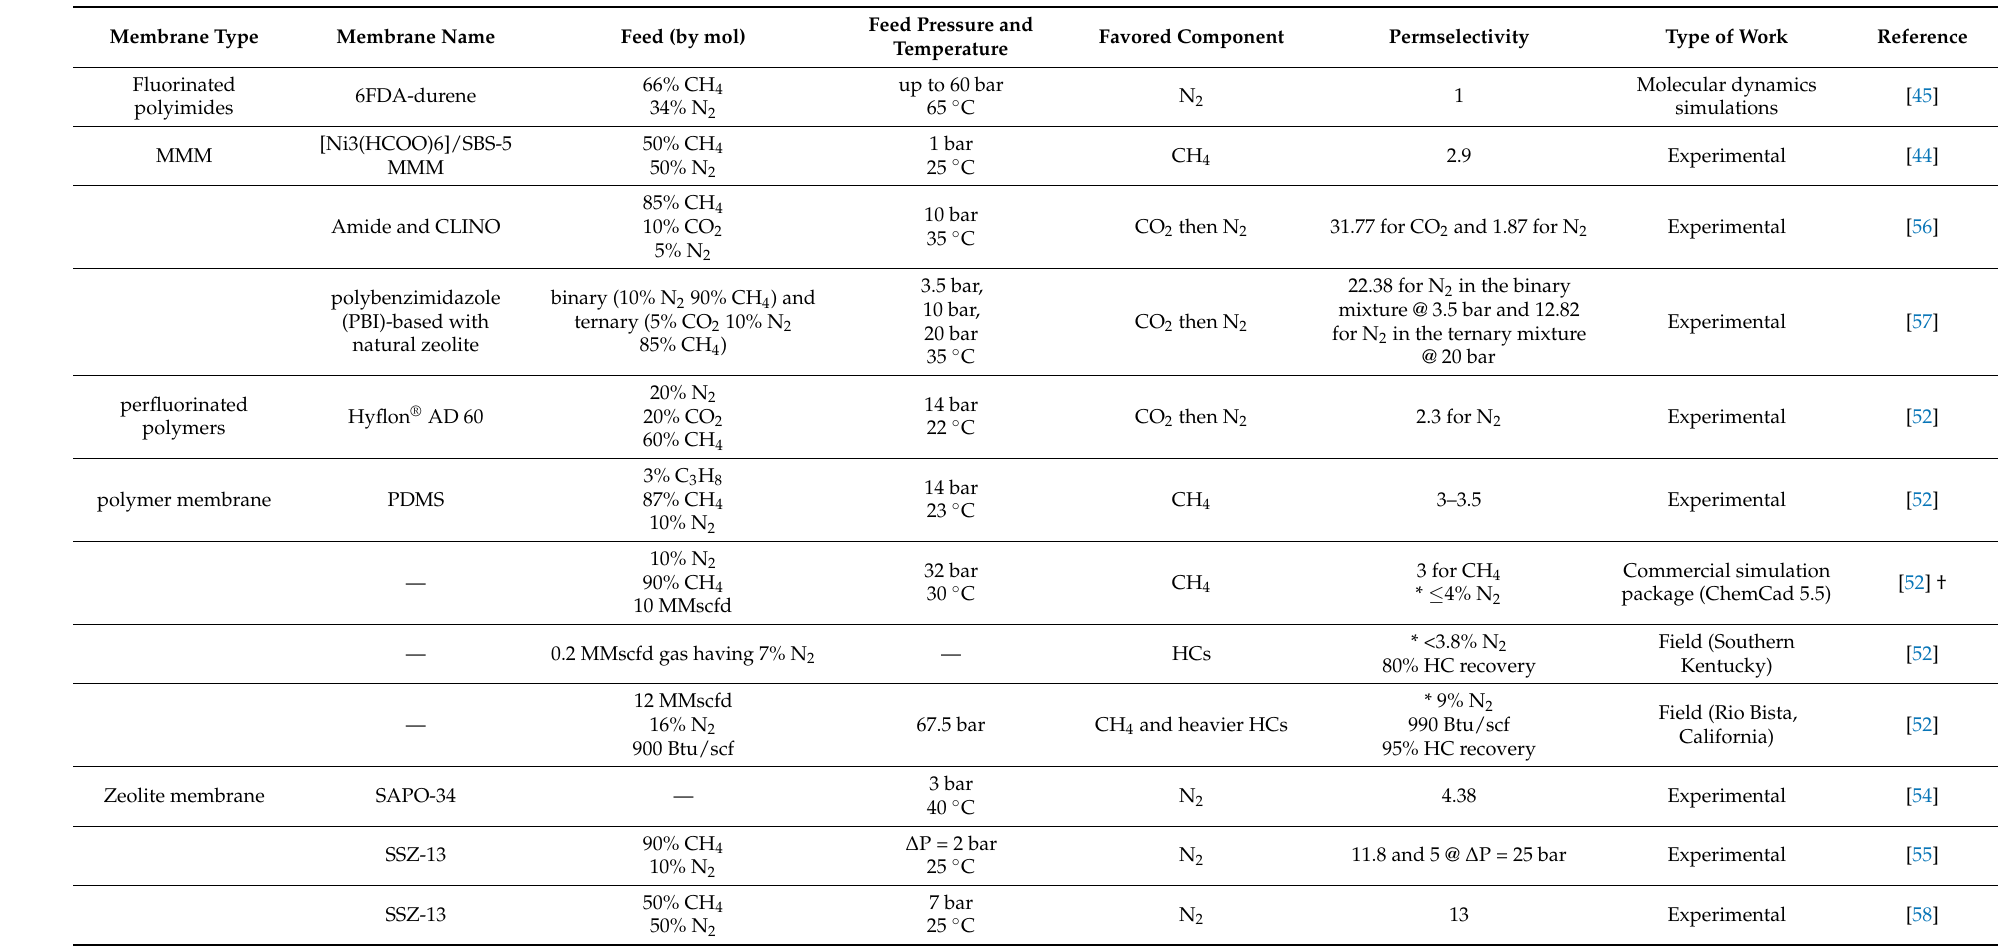
Table 2. Summary of the CH 4 /N 2 separation using